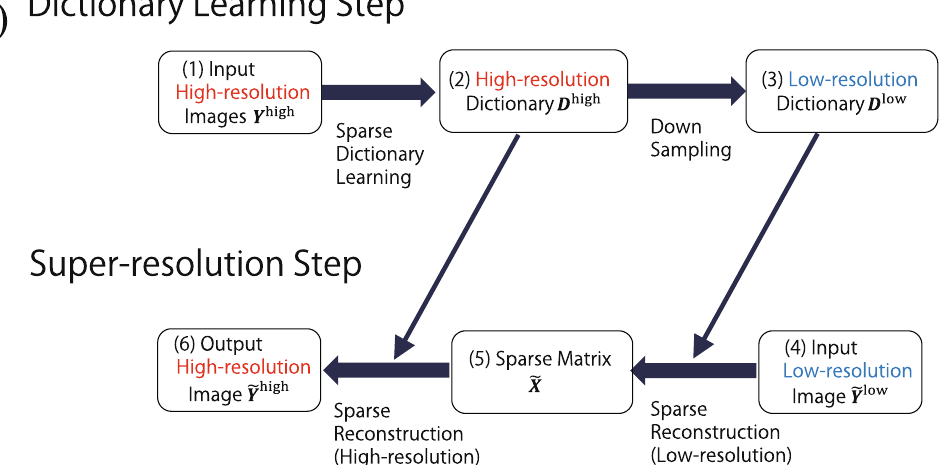
Figure 2. ( a ) Schematic illustration of the sparse super-resolution. ( b ) Flowchart of the proposed super- resolution algorithm for sparse